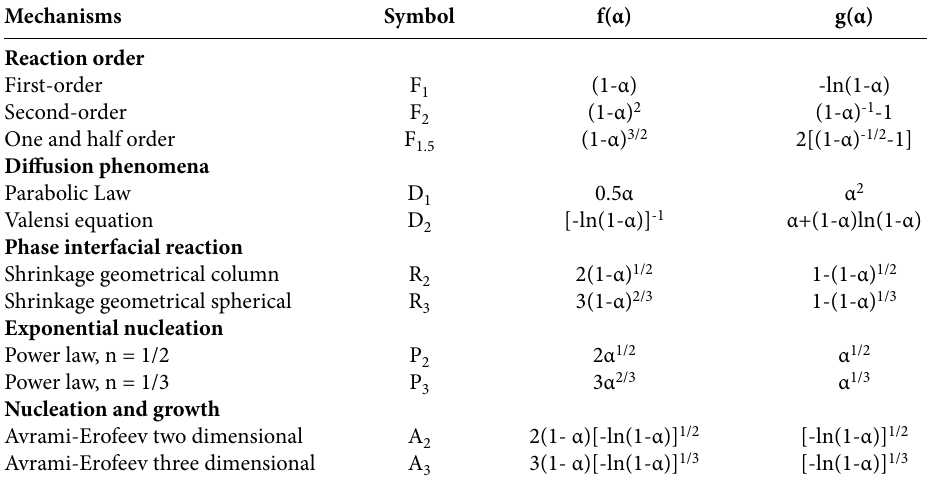
Table 1. Reaction mechanisms and symbols with their f(α) and g(α).